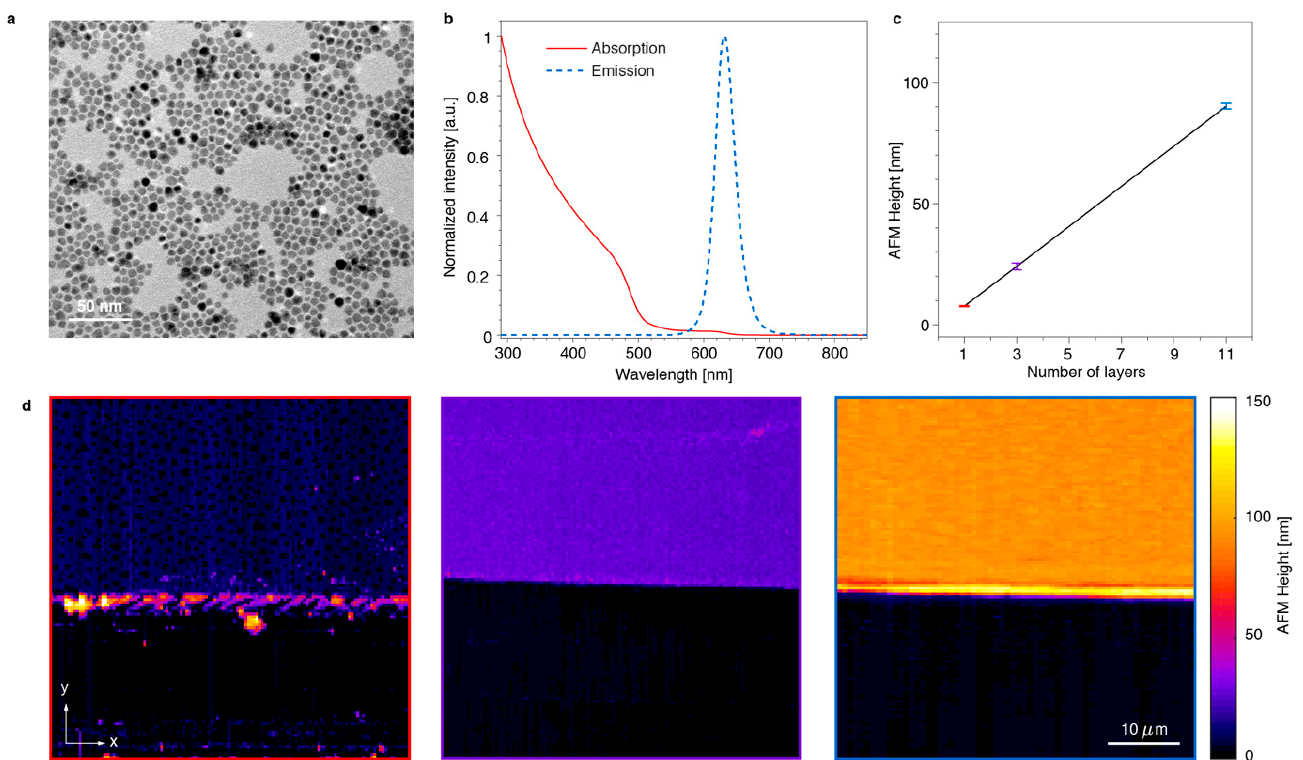
Figure 1. Fabrication and characterization of CdSe/CdS core/shell nanocrystals and thin films. Transmission electron microscopy image ( a ), absorption and emission spectra ( b ) of the synthesized CdSe/CdS nanoparticles. Atomic force microscopy (AFM) measurements of the thickness of the layered semiconductor nanoparticle (SNP) samples ( c ) with corresponding images ( d ) of a monolayer (left), three layers (middle) and eleven layers (right) of quantum dots.